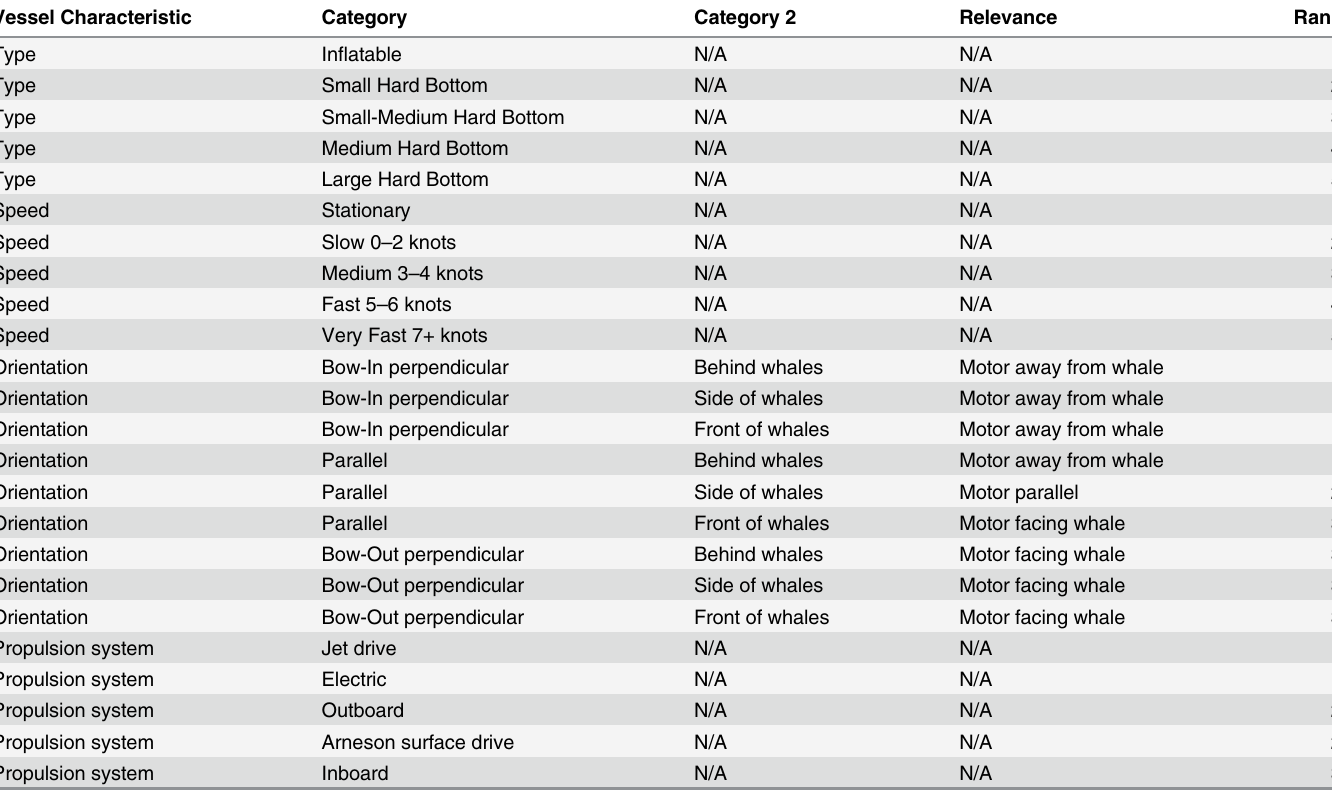
Table 1. Quantification of vessel characteristics.